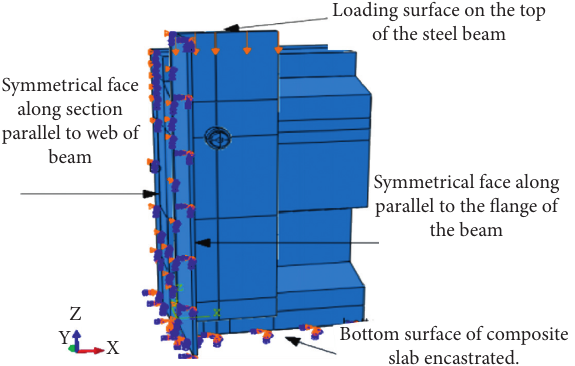
Loading surface on the top of the steel beam